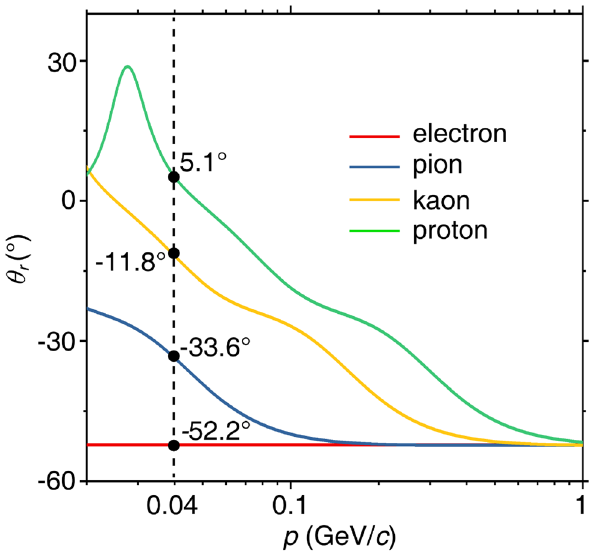
Figure 5: Radiation angles θ r of longitudinal Cherenkov photons versus particle momenta p .For comparison, four types of swift chargedparticlesarestudied,i.e.,electron,pion,kaon,andproton. When the momentum of charged particles is p = 0.04 GeV/c, the radiation angles θ r of longitudinal Cherenkov photons emitted by the electron, pion, kaon, and proton are − 52.2 ° , − 33.6 ° , − 11.8 ° , and 5.1 ° respectively. The studied wavelength is 129 nm, when longitudinal Cherenkov photons can be emitted by swift charged